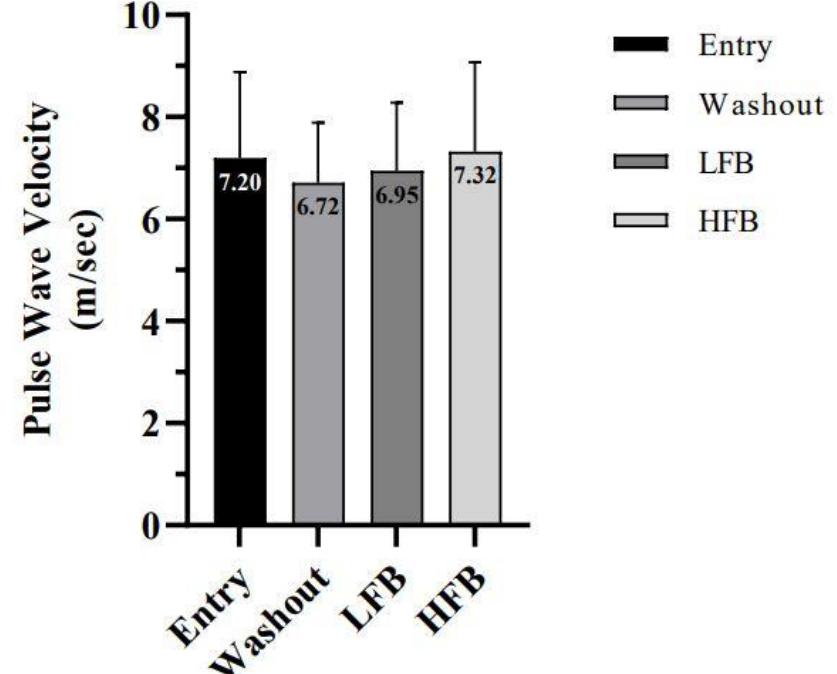
Figure 2. Carotid–femoral pulse wave velocity. Values are for entry, washout, LFB intervention, and HFB intervention. Cross-over design ( n = 23); values represent mean ± SD. Non-significant: p > 0.05.